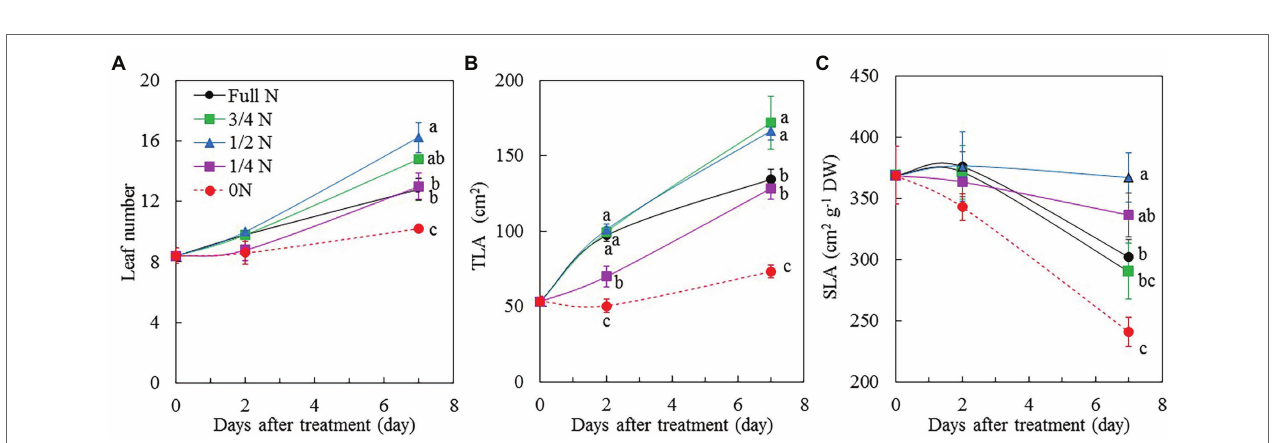
FIGURE 2 | Changes of leaf number (A) , total leaf area (TLA; B ), and specific leaf area (SLA; C ) of M. crystallinum after different NO 3– treatments. Vertical bars represent the SEs. Means with different letters are statistically different ( p = 0.05; n = 5) as determined by LSD multiple comparison